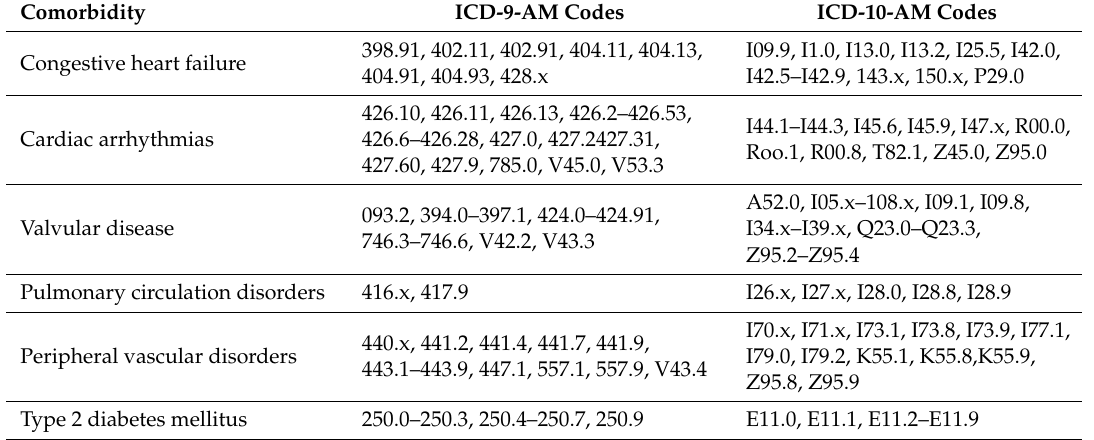
Table 2. ICD-9-AM and ICD-10-AM codes for cardiovascular disease (CVD) and type 2 diabetes mellitus (T2DM) (Adapted from Quan et al. [46]).